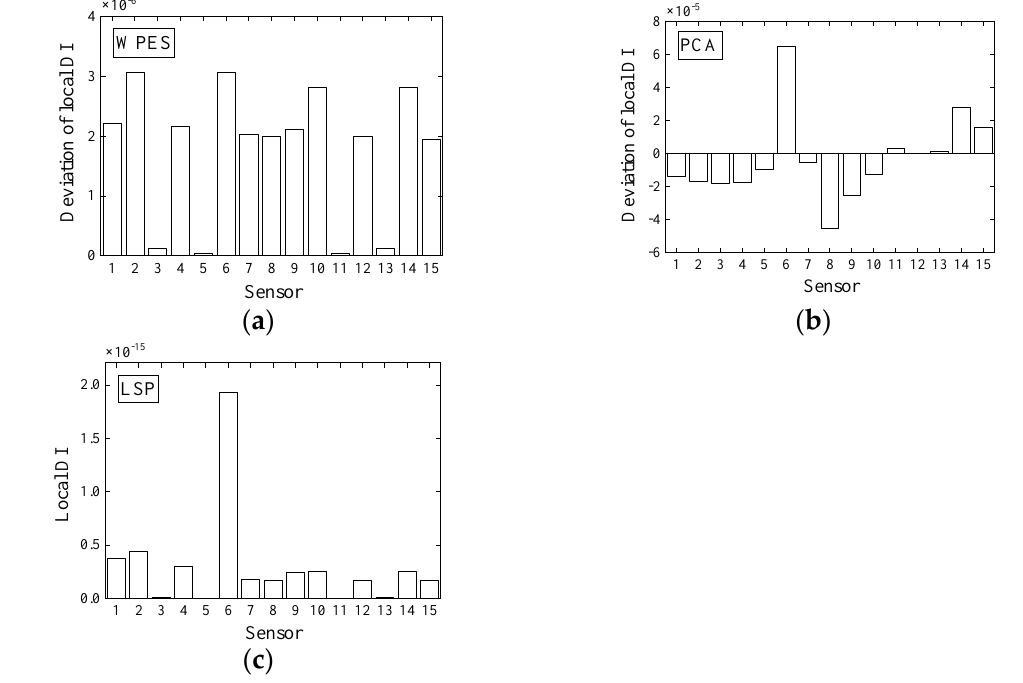
Figure 10. Deviations of local damage indicators corresponding to ( a ) WPES-only and WPES-based ( b ) PCA and ( c ) LSP methods respectively, when the first damage (1st DS) occurs (i.e., 111 s).